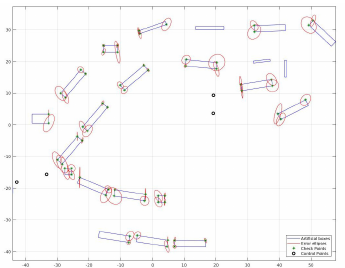
Figure 9. Error ellipses of the check points with scale factor of 50 Figure 7 and 8 visualizes the results of initial motion estimator